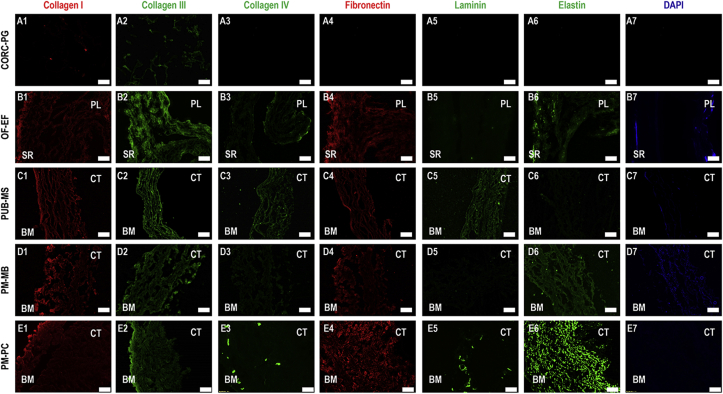
Immunohistochemistry analysis made apparent the presence of collagen type I, collagen type III, and fibronectin in all tissue grafts; collagen type IV in OF-EF, PUB-MS, and PM-PC; laminin in PUB-MS and PM-PC; and elastin in OF-EF, PM-MB, and PM-PC. Remaining cellular material was found in OF-EF and PM-MB. Scale bars 100 μm.